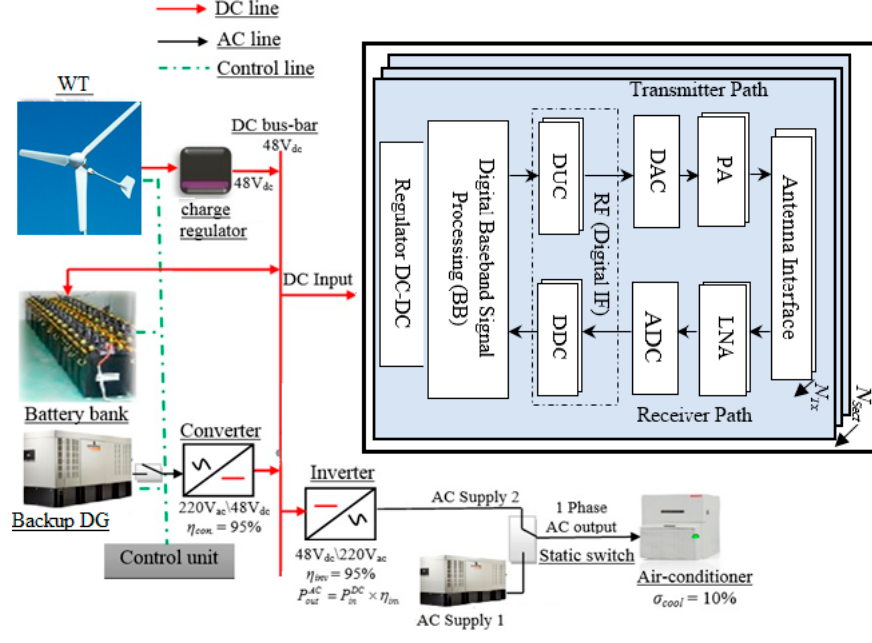
Figure 7. Scheme of the wind-powered BS.